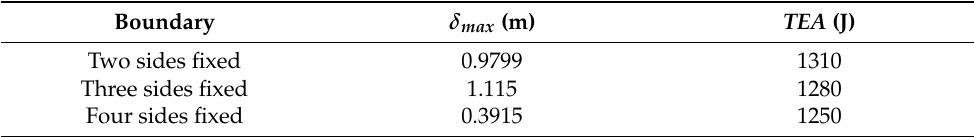
Table 8. The indices of different boundary